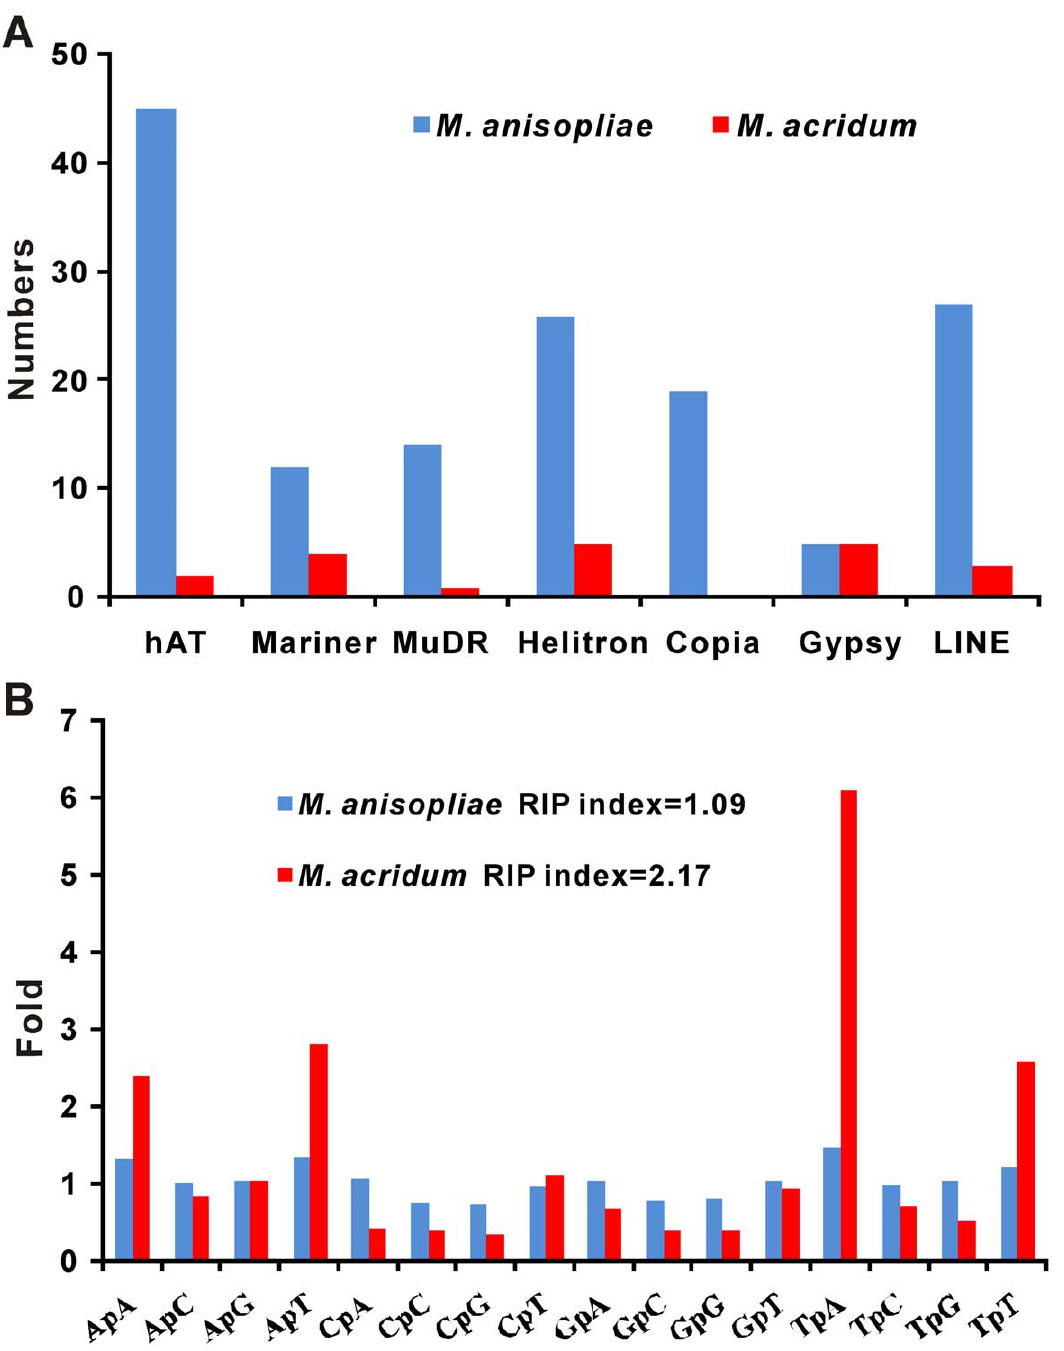
Figure 3. Families of transposase genes and estimation of RIP. Families of transposase genes (A) and estimation of RIP (B) in M. anisopliae and M. acridum . strated but they resemble the aspartyl proteases that assist the human pathogen C. albicans by degrading cell surface molecules [39]. Many plant pathogens need glycoside hydrolases, pectate lyases and cutinases to degrade the plant cuticle (waxy layer) and cell wall. The number of glycoside hydrolases (GH) possessed by M. anisopliae (156) and M. acridum (140) is close to the average for plant